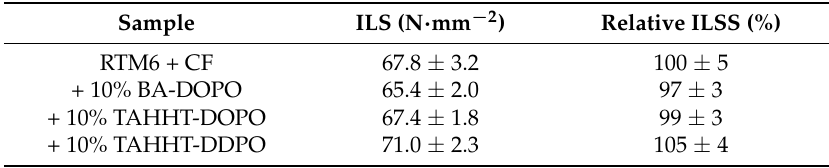
Table 4. Interlaminar shear strength (ILSS) of selected carbon fiber-reinforced thermoset polymers (CFRP) samples additionally normalized to RTM6 +